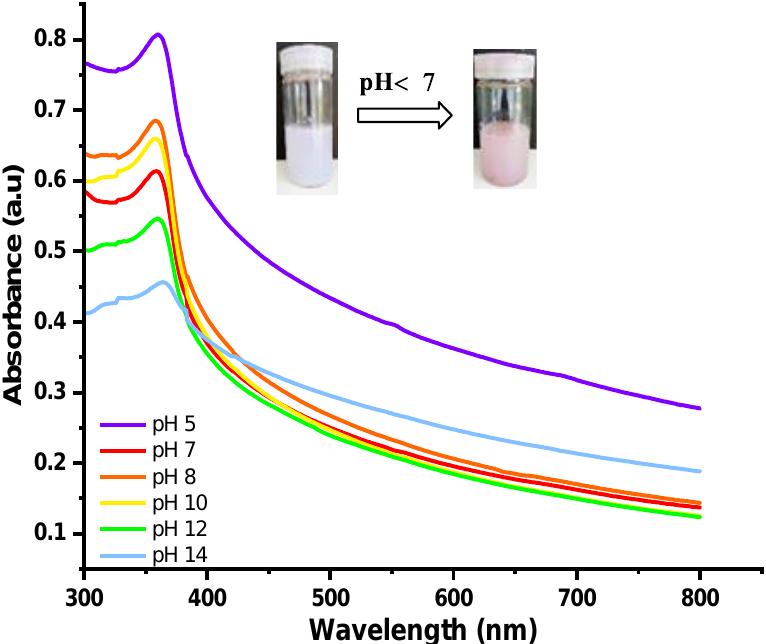
Figure 10. Absorbance spectra of PDA-ZnO-CMCs-HEC as a function of pH. Inset colour transition at higher pH.